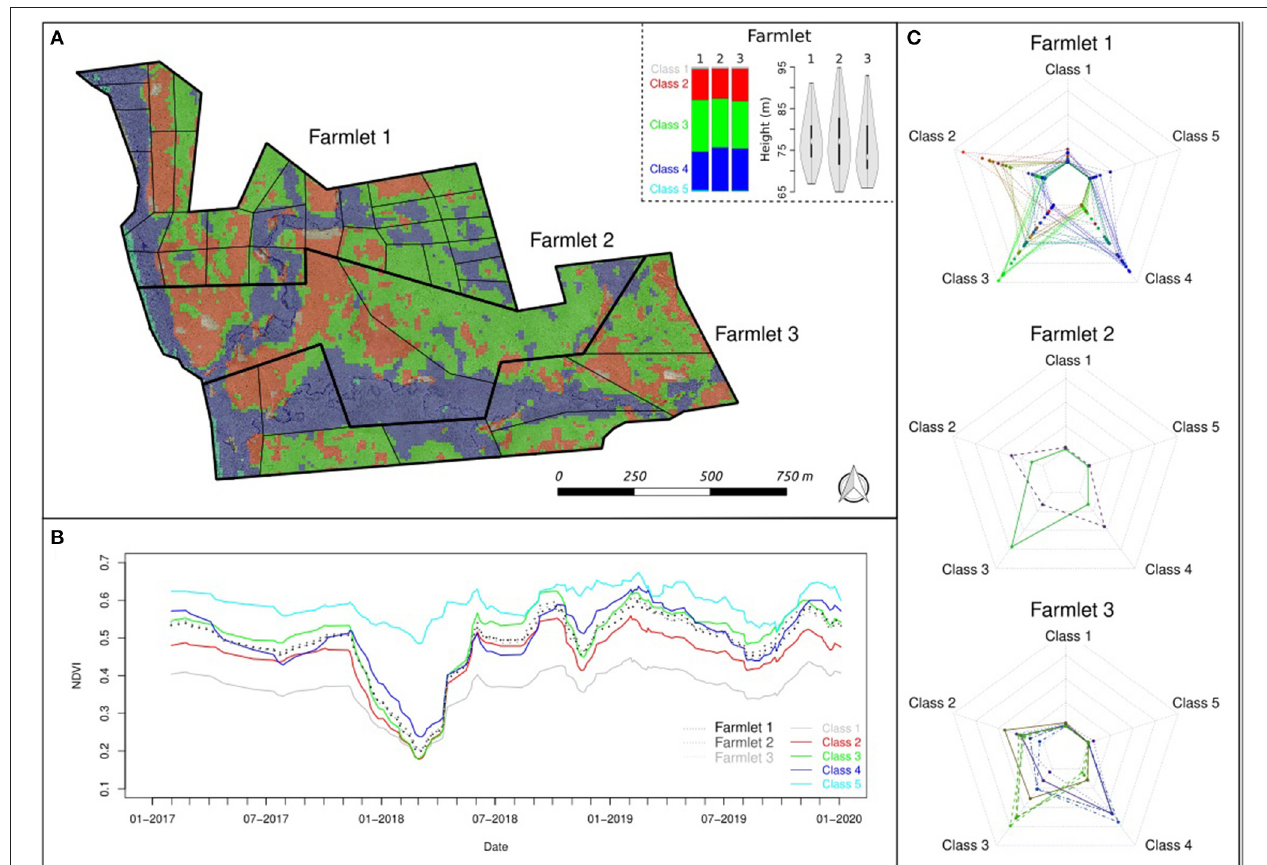
FIGURE 1 | (A) Map of vegetation classes (1, low vegetation cover, rocks; 2, shallow soil uplands; 3, deeper soil uplands; 4, depressed areas and lowlands; 5, streams), spatial allocation of farmlets (thick lines) and paddocks inside farmelts (thin lines). Box showing the proportions of vegetation classes and height distribution bay farmlet. (B) NDVI time series showing differences between the five vegetation classes (colors) and similarities between the three farmlets (grays). (C) Spyder plots showing the proportion of vegetation classes for the different paddocks of each farmlet. Colors of the points and lines representing each paddock are in line with the proportion of the more frequent vegetation classes (2 = red, 3 = green, 4 = blue). The greater the number of plots in the farmlet, the greater the chances of obtaining plots dominated by a vegetation